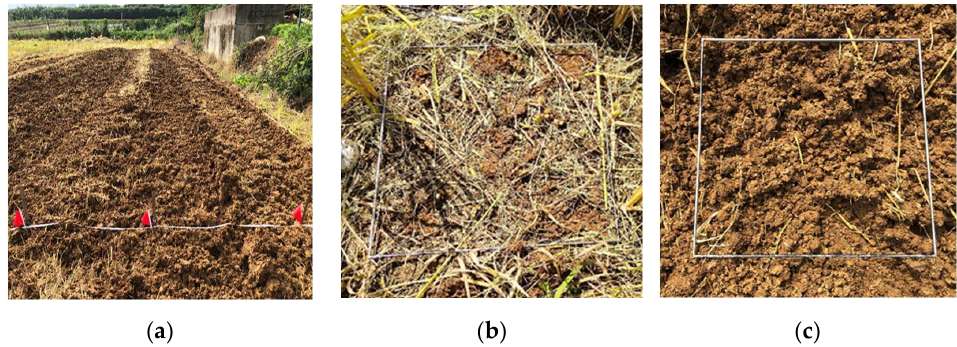
Figure 14. Measuring of operation quality. ( a ) measuring of tillage depth; ( b ) measuring the amount of stubbles before tillage; ( c ) measuring the amount of stubbles after tillage.